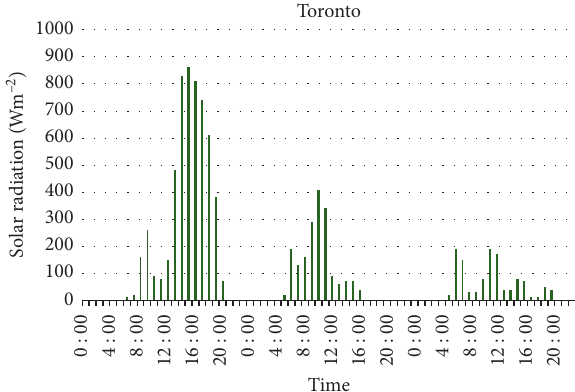
Figure 11: Solar radiation values in